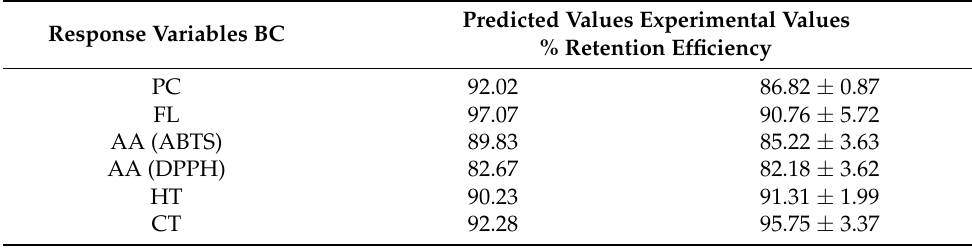
Table 3. Experimental and predicted values for all studied variables, for MD microencapsulated muicle leaves extract obtained with the optimum operating conditions (2 3 factorial design).